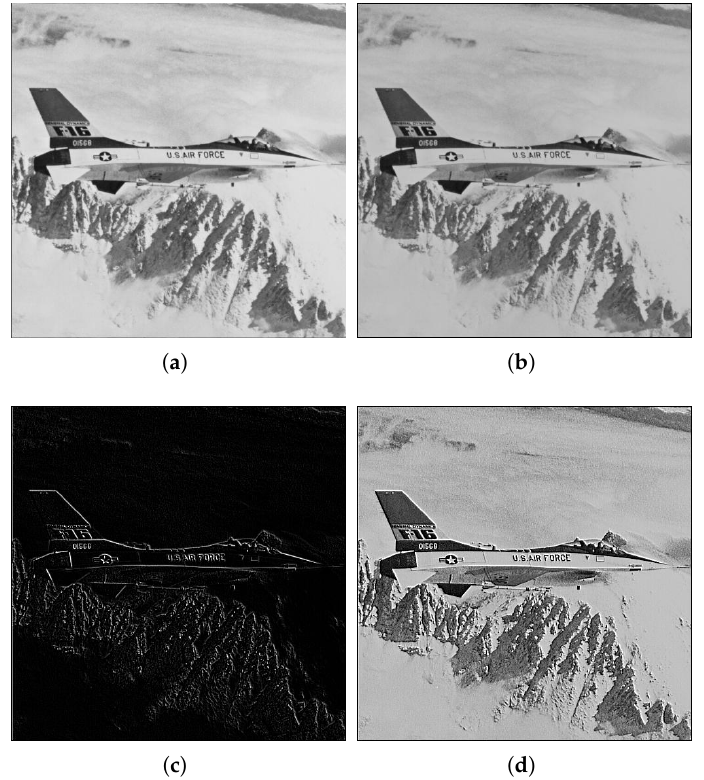
Figure 8. Example 1: results obtained using the three proposed stochastic computing CNN with different gene values. ( a ) Original image. ( b ) Stored image. ( c ) Edge detection result. ( d ) Sharp- ened image.